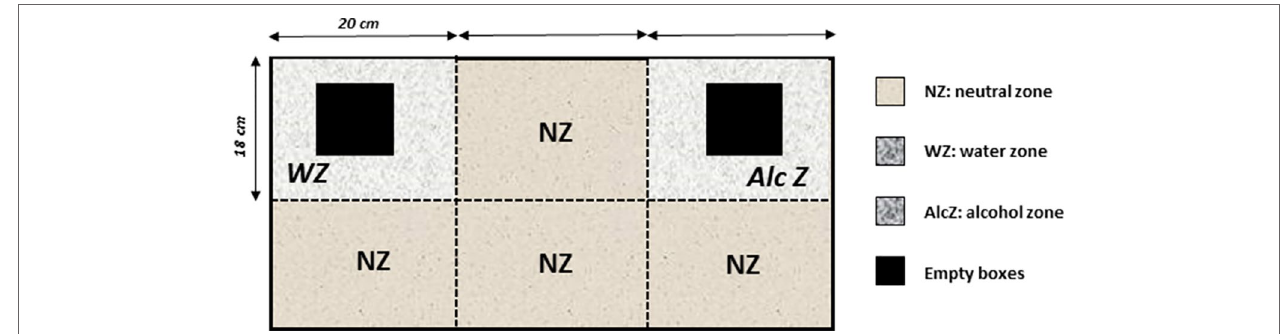
FIGURE 2 | The odor recognition task. The apparatus is a rectangular chamber made of transparent Plexiglas. The floor was covered with sawdust and divided into separates zones that are wet either with water (water zone, WZ, neutral odor) or with a 12% alcohol solution (alcohol zone, AlcZ), with the remaining space being a neutral zone (NZ) covered only with dry sawdust. To enhance exploration, two identical familiar empty gray Plexiglas boxes were placed in the water and alcohol zones (empty boxes, black squares). The times spent exploring the water and alcohol zones were recorded, and a discrimination ratio was calculated (Time in AlcZ/Time in